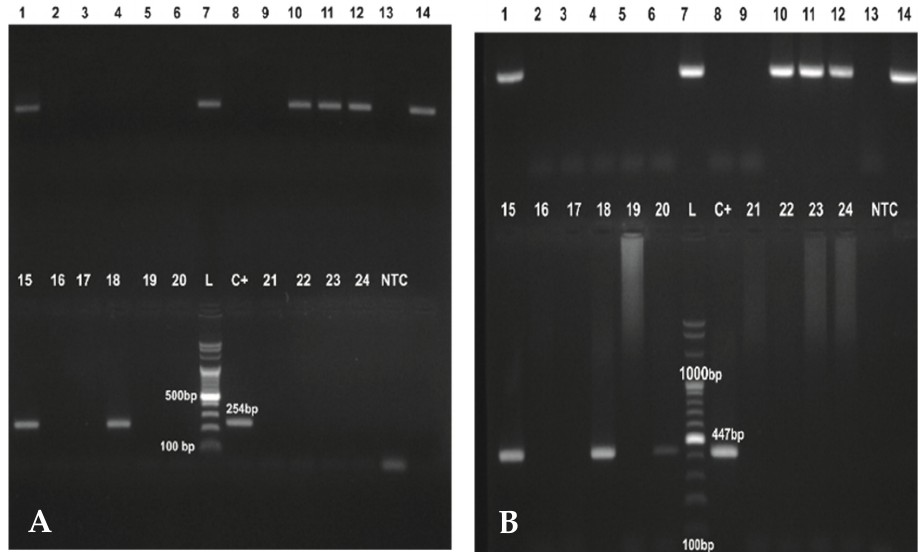
Figure 2. PCR products of nPCR of Borrelia burgdorferi s.l. 5S–23S intergenic spacer (panel ( A )) and FlaB (panel ( B )) analyzed on a 1.5% agarose gel electrophoresis. The same DNA templates were used in both nPCRs. L: DNA ladder in 100 bp increments; C+: DNA from positive control; NTC: non-template control.